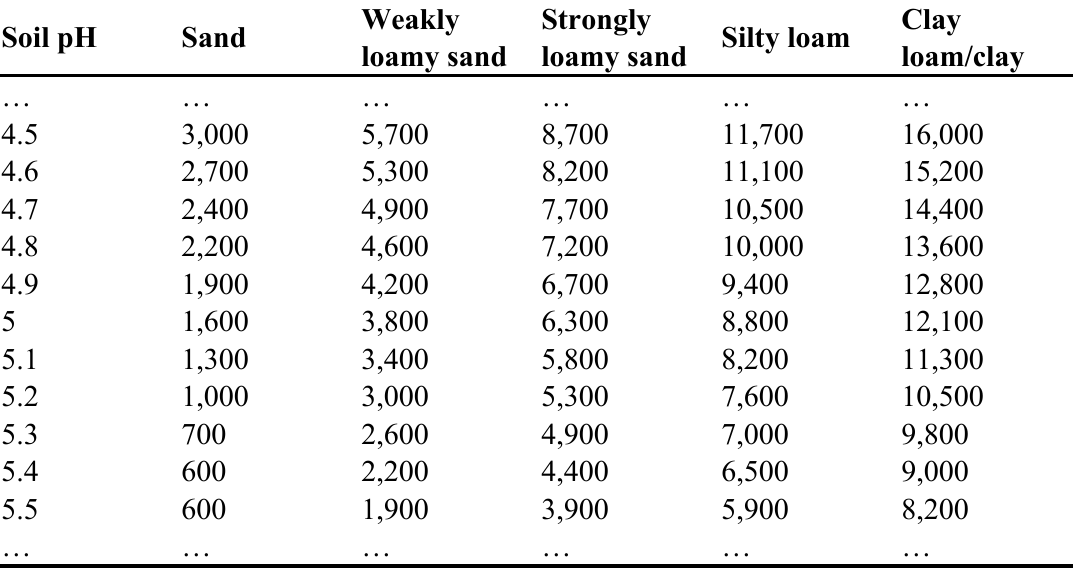
Table 2. German recommendation table for liming (kg ha − 1 ). Excerpt from [49] showing recommendation only for soil pH values within the range of 4.5 to